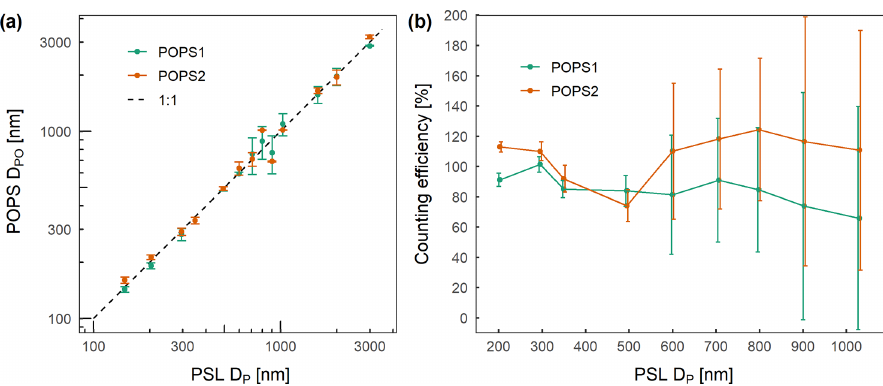
Figure 3. (a) Measured optical particle diameter ( D PO ) by two POPS, determined by lognormal fits on the measured particle number size distribution of mobility diameter ( D P )-selected PSL particles. (b) Counting efficiencies of the two POPS measured against a reference CPC during the PSL